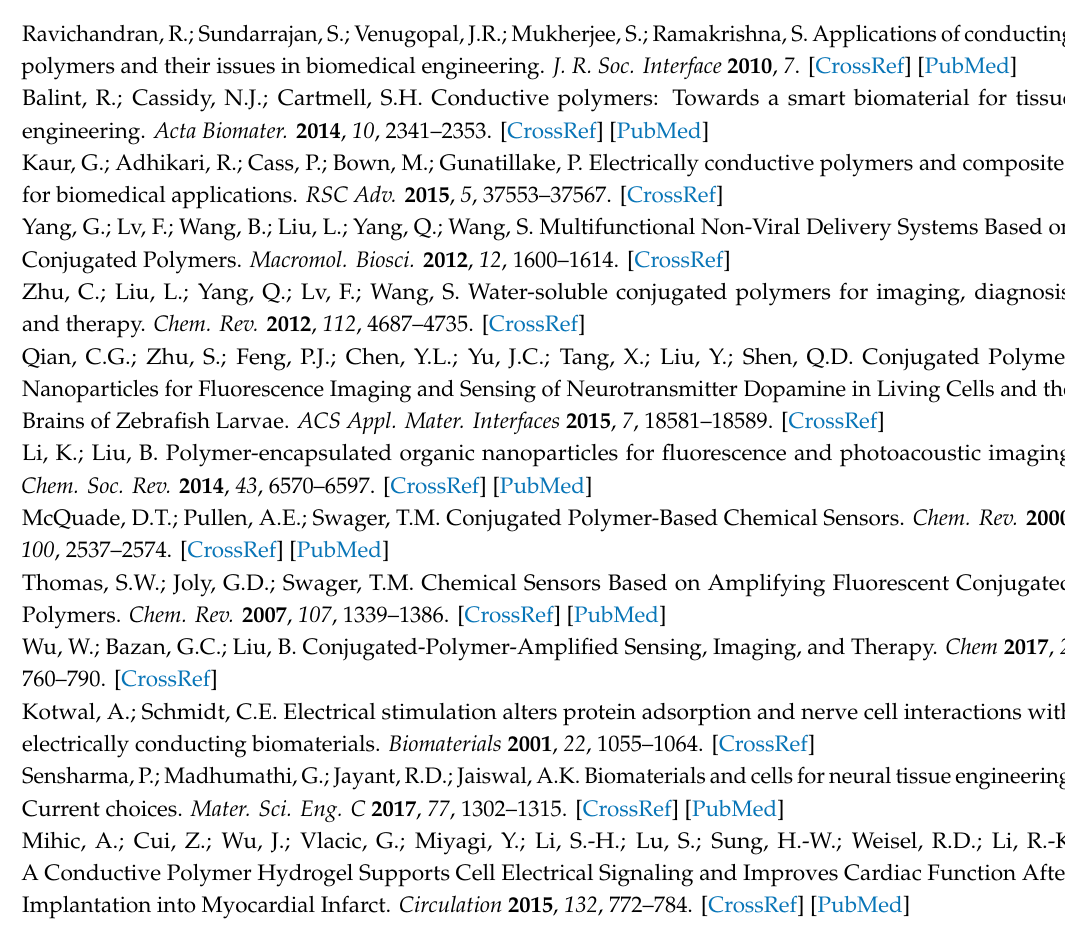
Figure S1: Schematic of the major component of the streaming current measurements setup; Figure S2: High magnification fluorescence microscope image of fibroblasts; Figure S3: Scanning electron micrograph of single-walled carbon nanotubes; Figure S4: Scanning electron micrograph of Si / SiO 2 sample with bovine serum albumin; Figure S5: ζ -potential values of Si / SiO 2 samples with composite films as a function of pH value for 1 mM KCl electrolyte; and Table S1: Components and composition of the used water